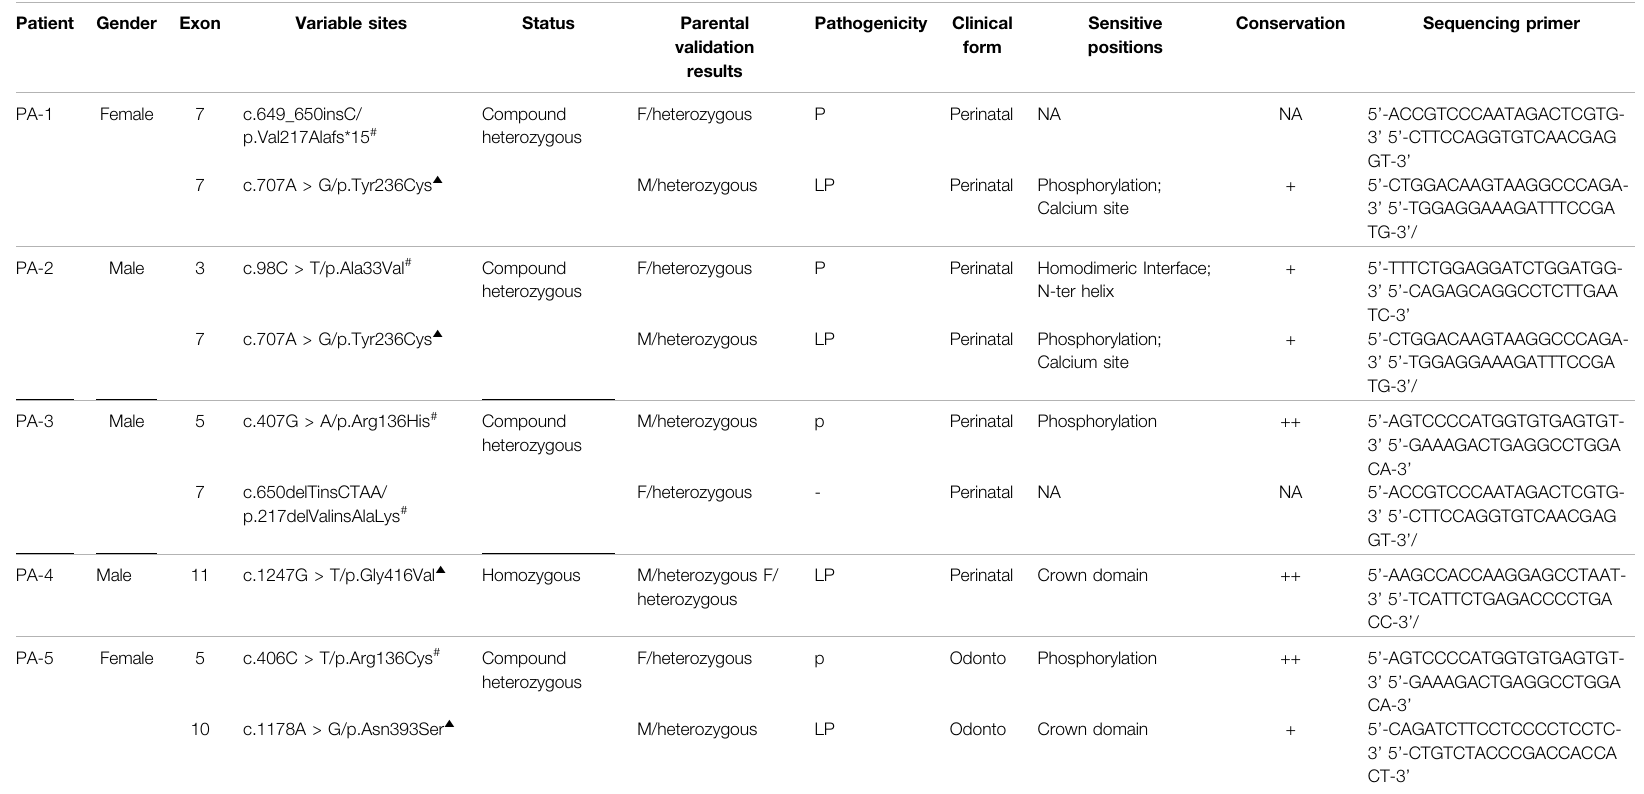
TABLE 2 | Five patients with ALPL gene